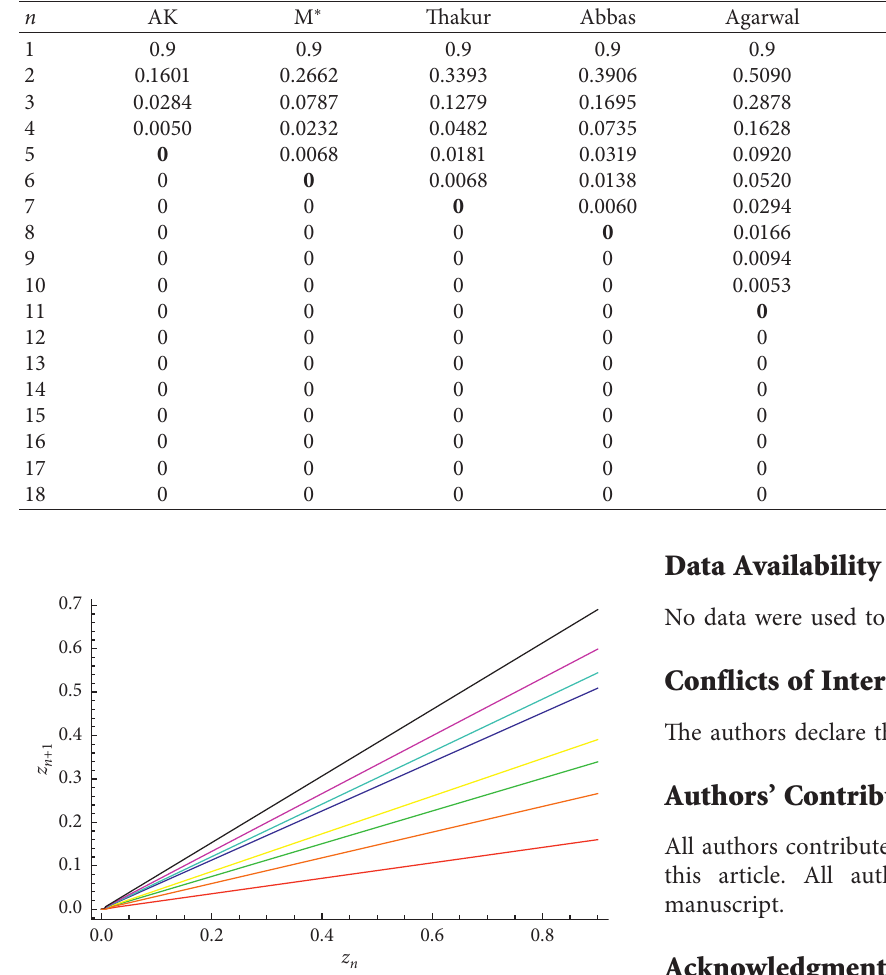
Figure 1: Convergence behavior of AK (red line), M ∗ (orange line), Thakur (green line), Abbas (yellow line), Agarwal (blue line), Noor (cyan line), Ishikawa (magenta line), and Mann (black line) iterates for mapping J defined in Example 1 where z